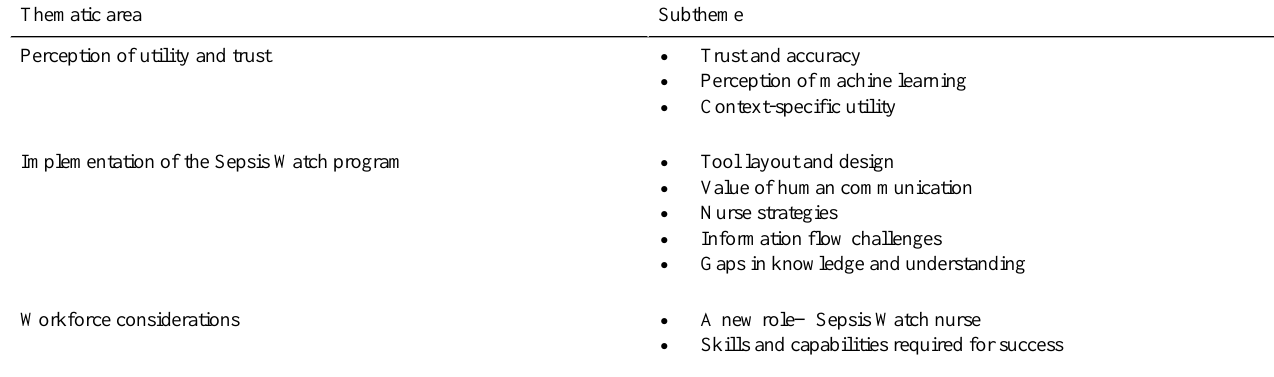
Table 3. Thematic area and corresponding